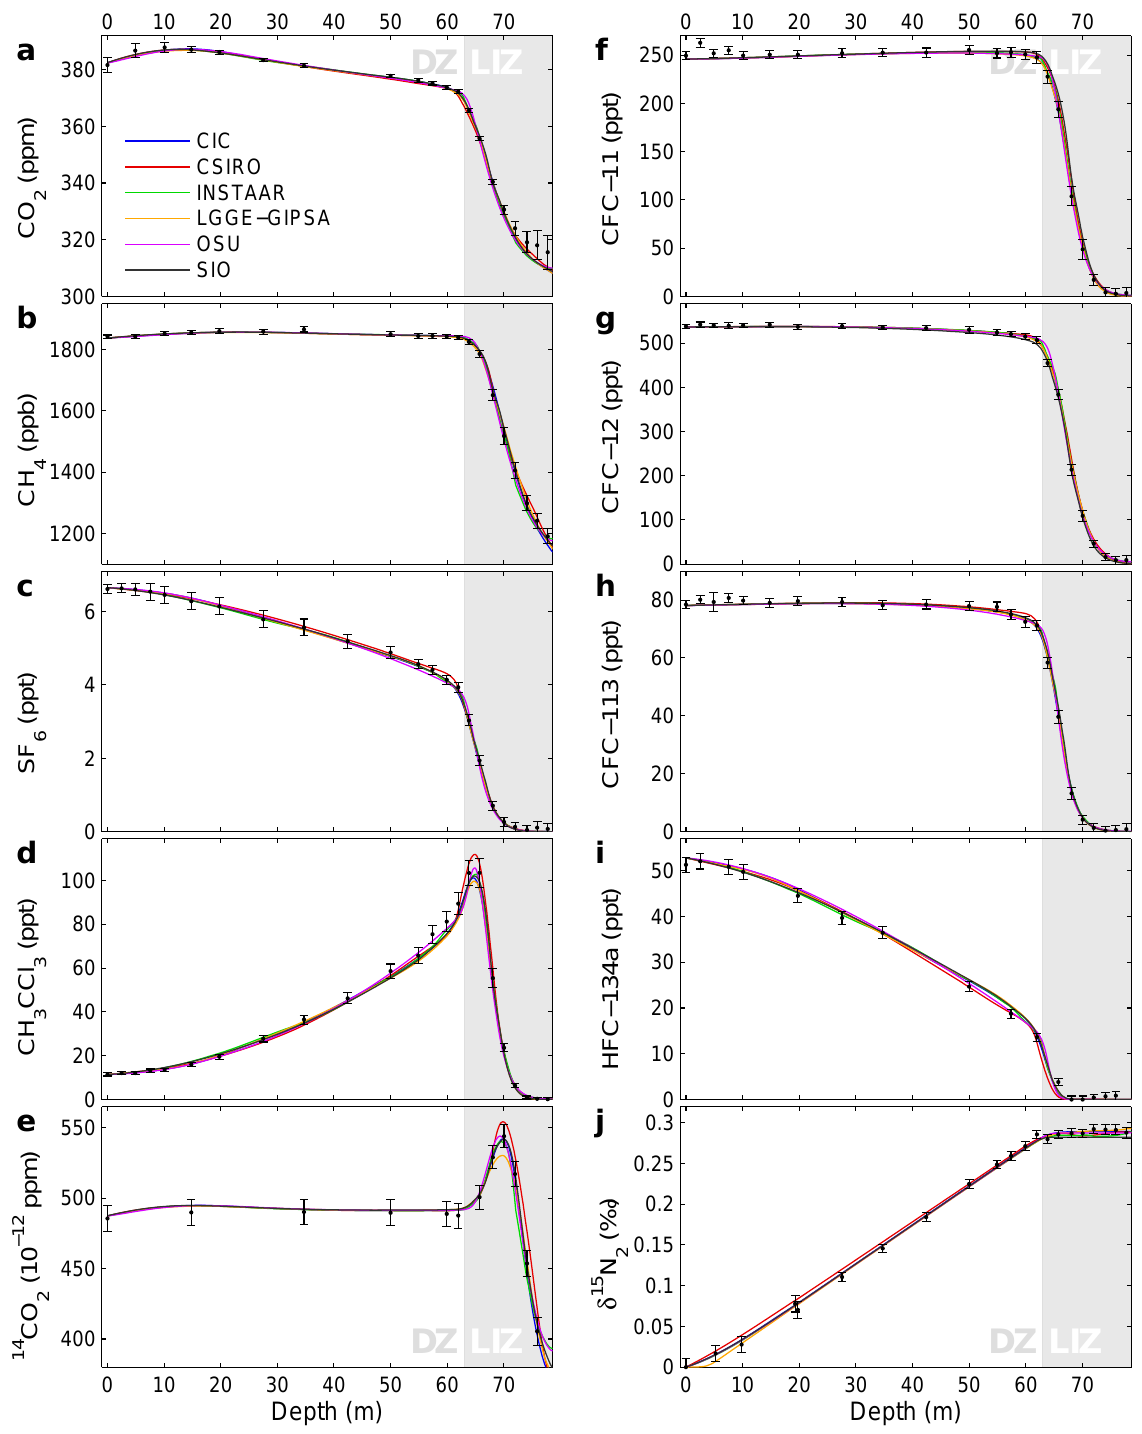
Fig. 3. (a–j) Modeled profiles for all 10 tracers from the EU borehole. With the exception of (j) data are gravity corrected and the models are run with gravity turned off. Errorbars correspond to full 1 σ uncertainty as defined in Sect.